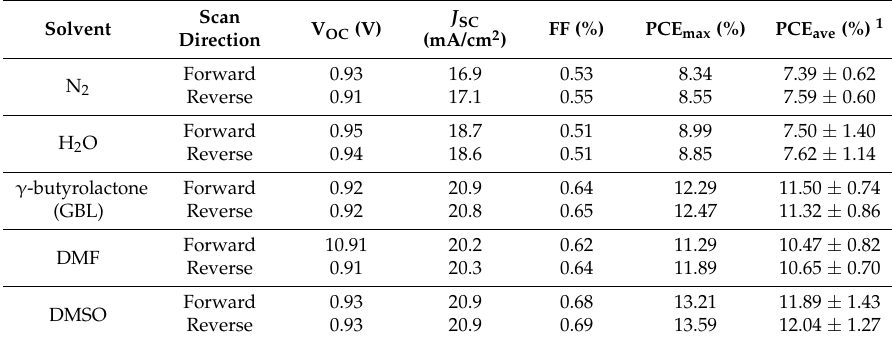
Table 2. Parameters of Devices Annealed under Different Atmospheric Conditions [115]. Copyright © 2015, American Chemical Society.